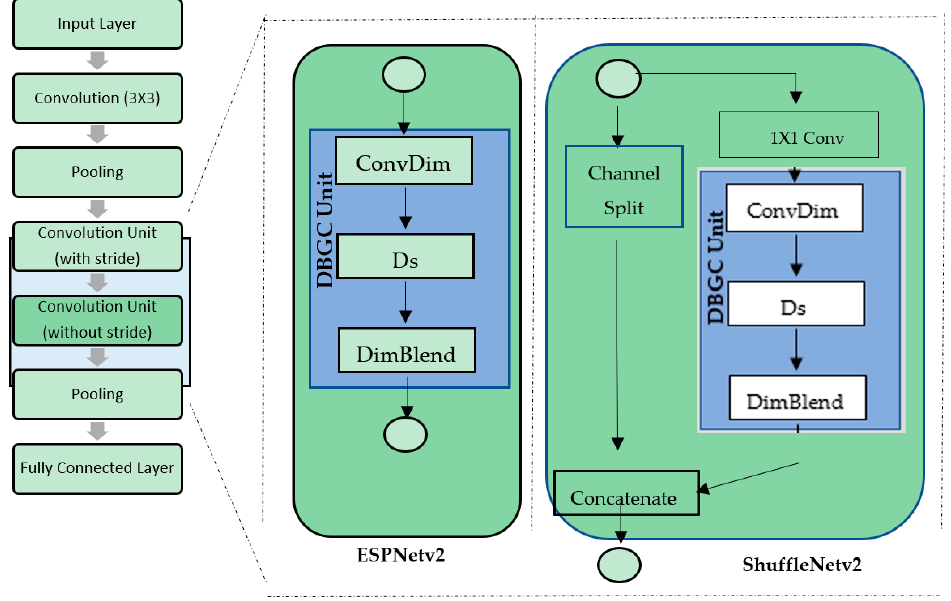
Figure 14. The DBGC unit in different architecture (ESPNetv2 and ShuffleNetv2) designs.